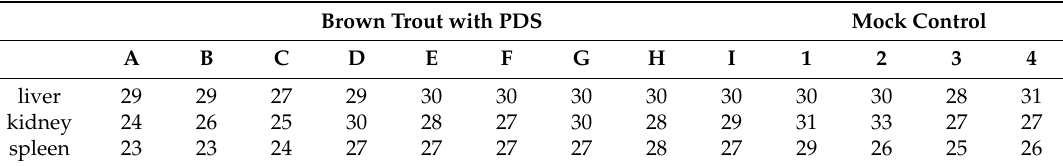
Table 1. PRV-3 in the brown trout from the exposure experiment in 2008. The virus specific RNA in the liver, kidney, and spleen was detected using RT-qPCR (Cq values are